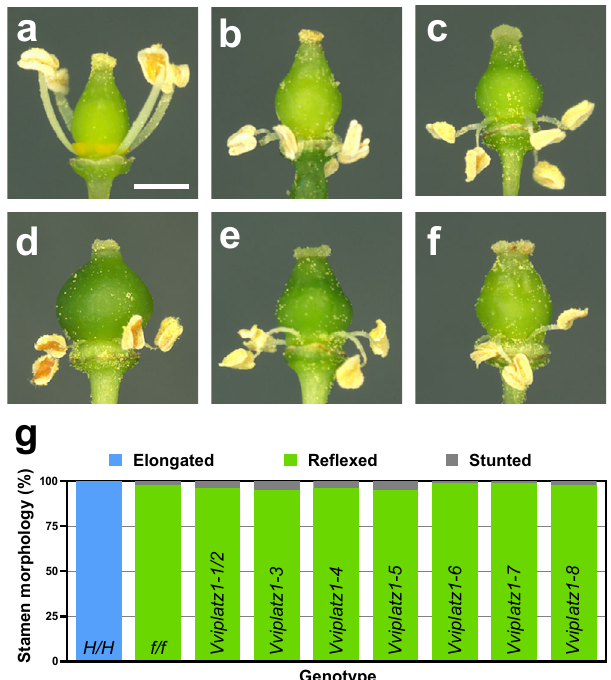
Fig. 4 Re fl ex stamen development is controlled by loss of VviPLATZ1 function. Representative images of fl owers derived from ( a ), 04C023V0006 ( H/H; VviPLATZ1/VviPLATZ1 ); ( b ) 04C023V0003 ( f/f; Vviplatz/Vviplatz ); ( c ) homozygous Vviplatz1-3 ; ( d ) Vviplatz1-5 ; ( e ) Vviplatz1-7 ; ( f ) Vviplatz1-8 plants. g Quanti fi cation of stamen architecture in 04C023V0006, 04C023V0003, and homozygous mutated plants. Elongated stamens (blue) with an upright growth pattern and an average length equal to 3.0 mm was initiated in H/H fl owers. Re fl ex stamens that bend away from the pistil were produced in f/f and homozygous mutated fl owers (green). In addition, 1 – 5% of the stamens initiated in f/f and homozygous mutated fl owers were stunted and grew to an average length of 1.2 and 1.4 mm, respectively. The scale bar is 1.0 mm and is representative for all fl ower images ( a – f ). Source data underlying Fig. 4g are provided as a Source Data fi